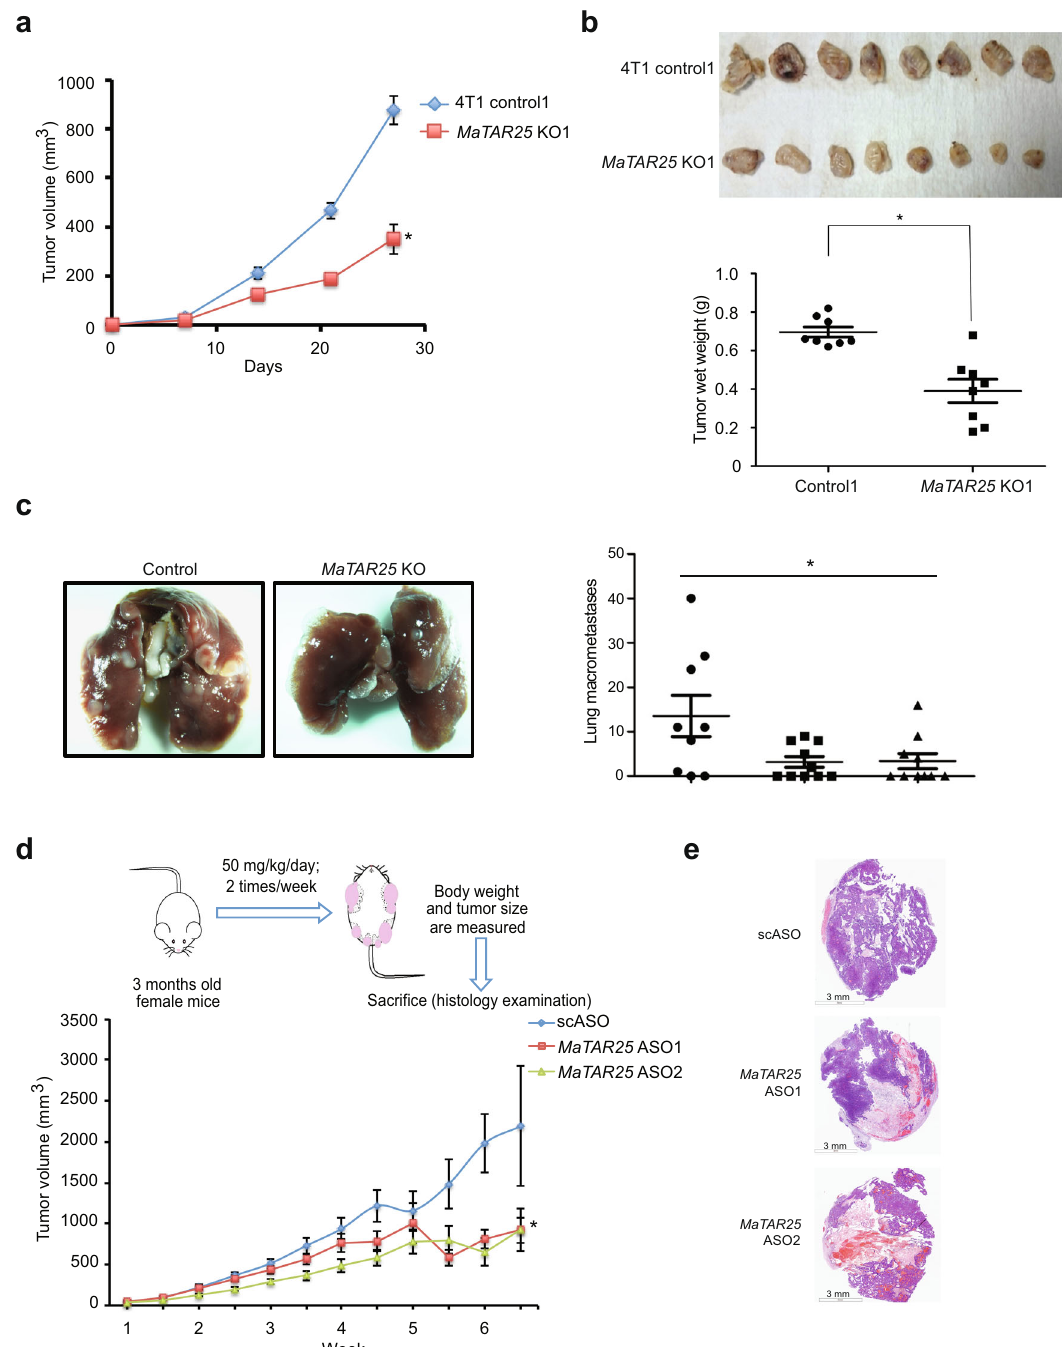
Fig. 3 MaTAR25 knockout impairs tumor growth and metastasis in vivo. a 4T1 control or MaTAR25 KO cells were injected orthotopically into